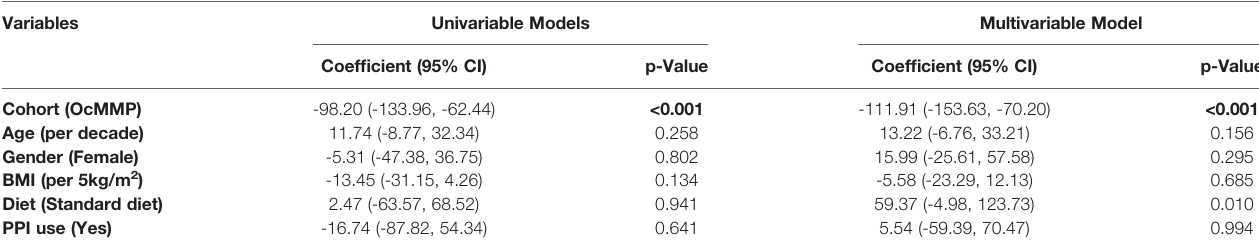
TABLE 3 | Linear regression models of number of OTUs in OcMMP vs. healthy controls.